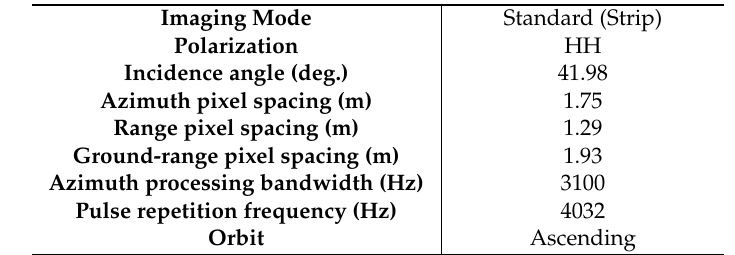
Figure 1. Kompsat-5 single look complex (SLC) image used for this study. ( a – d ) indicate the sub-images magnified from the A to D boxes in the Kompsat-5 SLC image. Table 1. Kompsat-5 single look complex (SLC) synthetic aperture radar (SAR) data information. HH: horizontal transmitting and horizontal